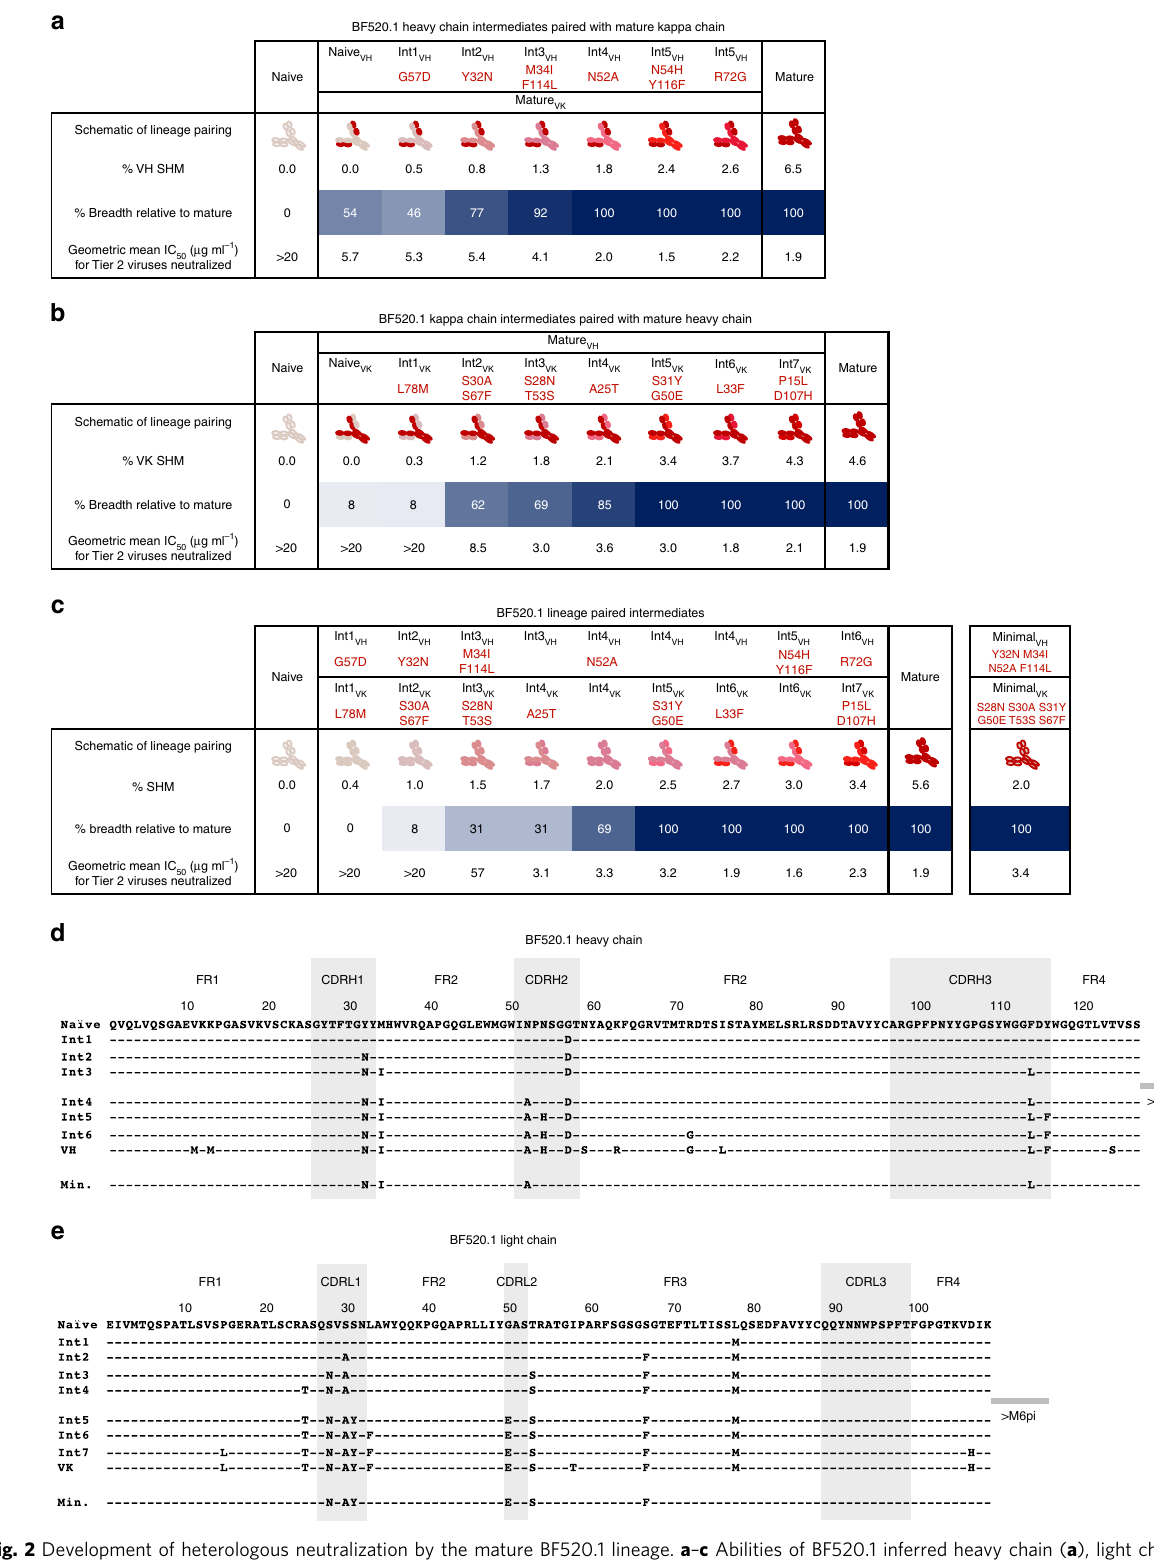
Fig. 2 Development of heterologous neutralization by the mature BF520.1 lineage. a – c Abilities of BF520.1 inferred heavy chain ( a ), light chain ( b ), and paired ( c ) lineage intermediates to neutralize a multi-clade and multi-tier panel of 13 viruses, all of which are neutralized by mature BF520.1. Heavy- and light-chain pairings are indicated along the top row (black text) along with progressive amino acid substitutions (red text). Schematics depict antibody lineage pairings with darker red shades indicating greater maturity. Breadth percentages refer to neutralization of viruses within the 13-virus panel with IC 50 values of < 20 µ g ml − 1 ; darker blue shades indicate increased breadth. SHM percentages refer to nucleotide mutation. Geometric mean IC 50 values (in µ g ml − 1 ) refer to Tier 2 viruses only. d , e Amino acid alignment of BF520.1 naive, Bayesian (0 – 6 months pi) and rationally inferred (6 – 12 months pi) lineage intermediates, mature, and minimally mutated heavy ( d ) and light ( e ) chain